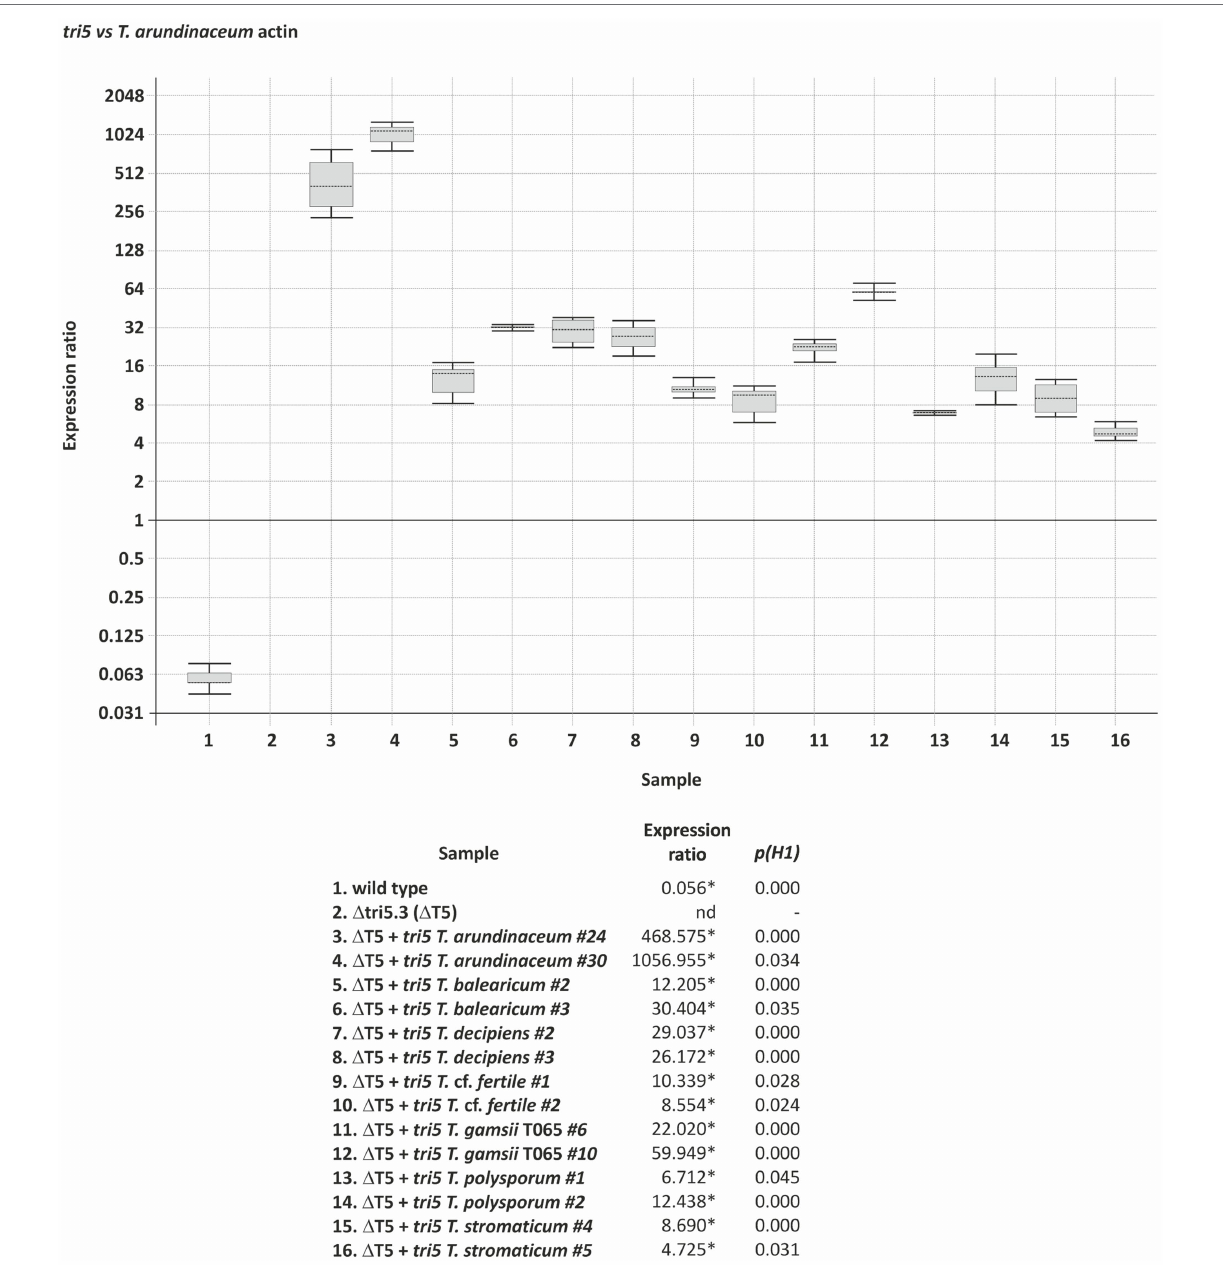
FIGURE 8 | tri5 expression in T. arundinaceum strains generated in the complementation analysis. Values are derived from Real Time quantitative PCR (qPCR) analysis and are the ratio of the level of expression of tri5 versus the actin gene. Strains: wild type – wild-type T. arundinaceum , and Δ tri5.3 ( Δ 5) – T. arundinaceum Δ tri5 deletion mutant. The 14 other strains are transformants of Δ tri5.3 expressing tri5 homologs from seven Trichoderma species. Statistically significant expression ratio values [ p(H1) < 0.05] are indicated with an asterisk. nd indicates not